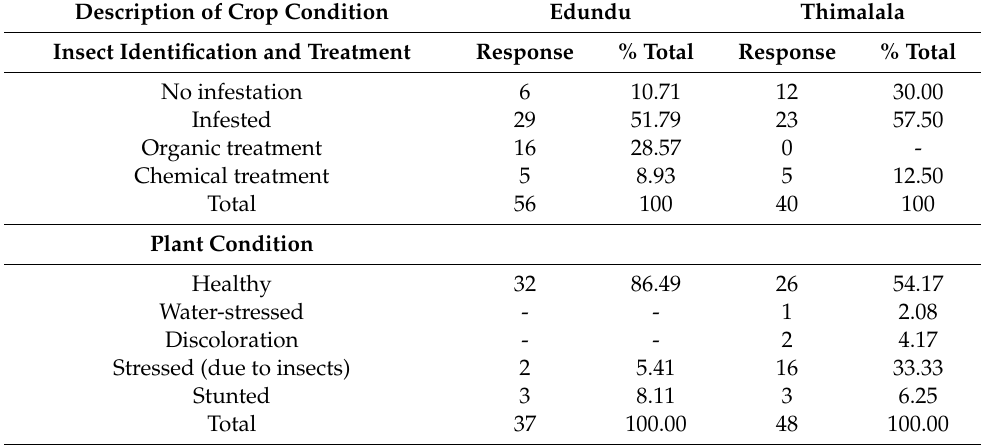
Table 4. Description of farm conditions based on farmers’ observation ( n = 37